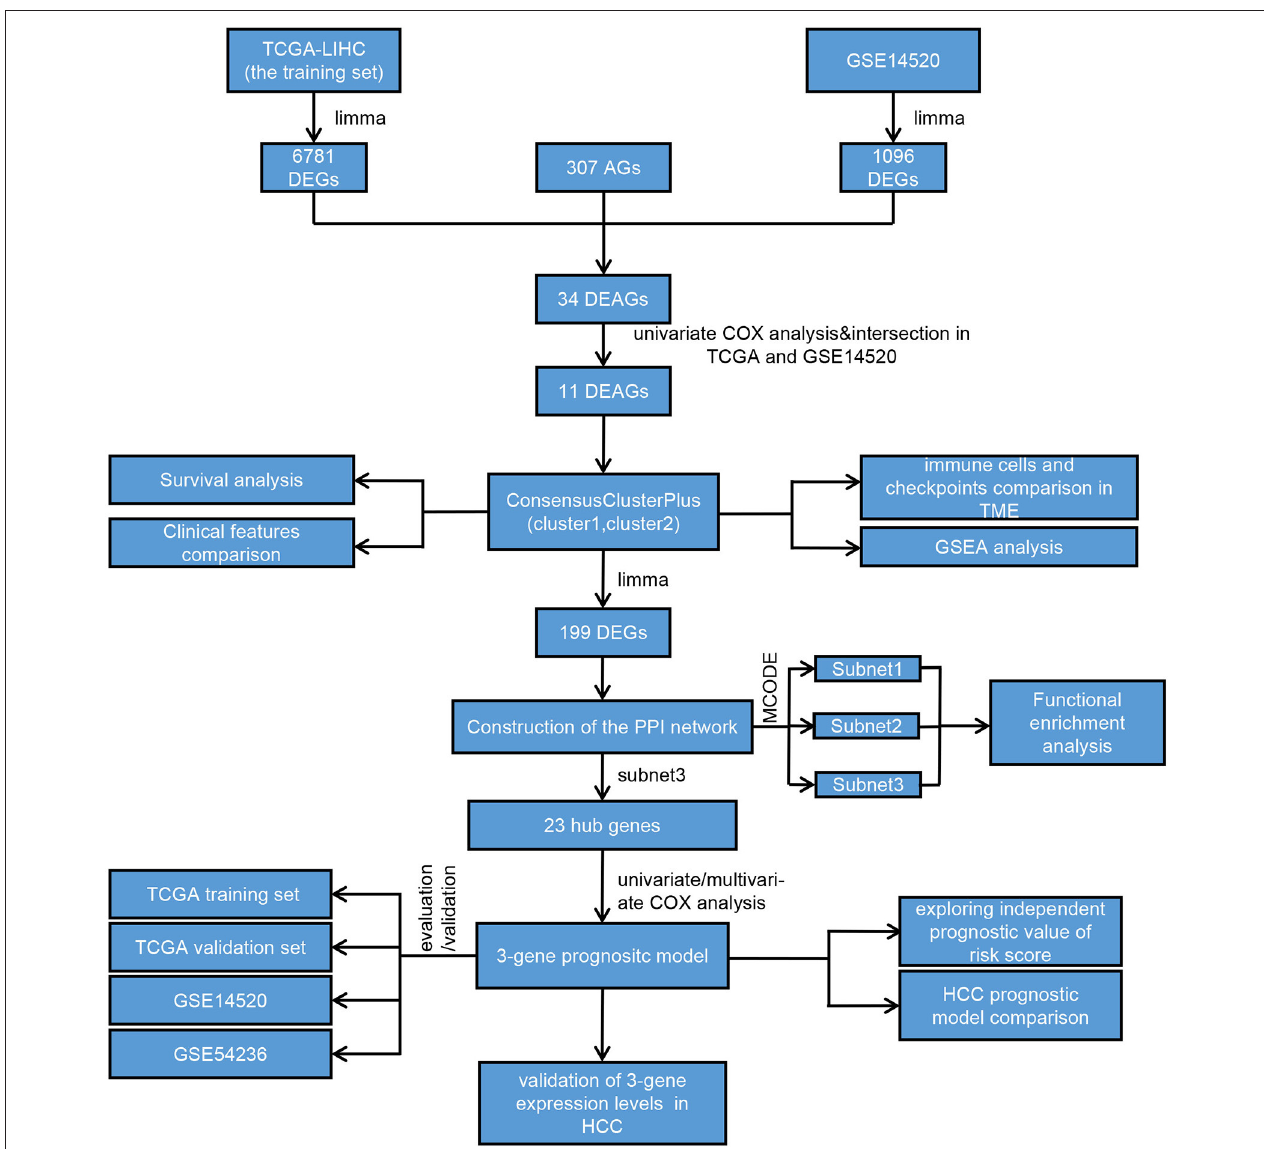
FIGURE 1 | Flowchart of the overall